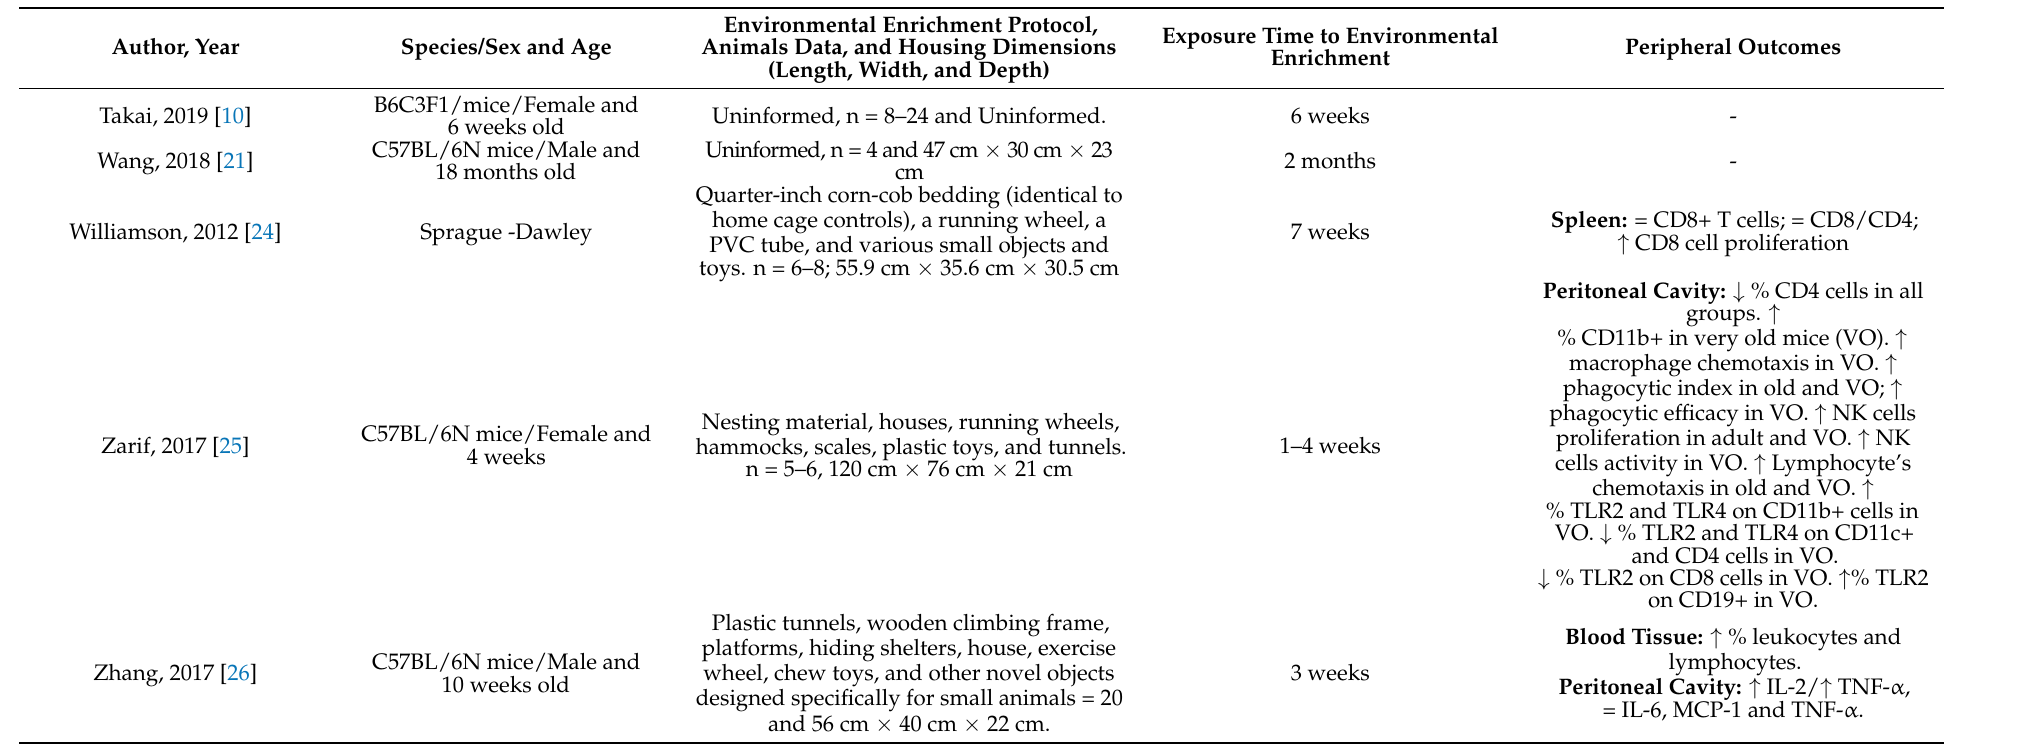
Blood Tissue: ↑ % leukocytes and lymphocytes. Peritoneal Cavity: ↑ IL-2/ ↑ TNF- α , = IL-6, MCP-1 and TNF- α